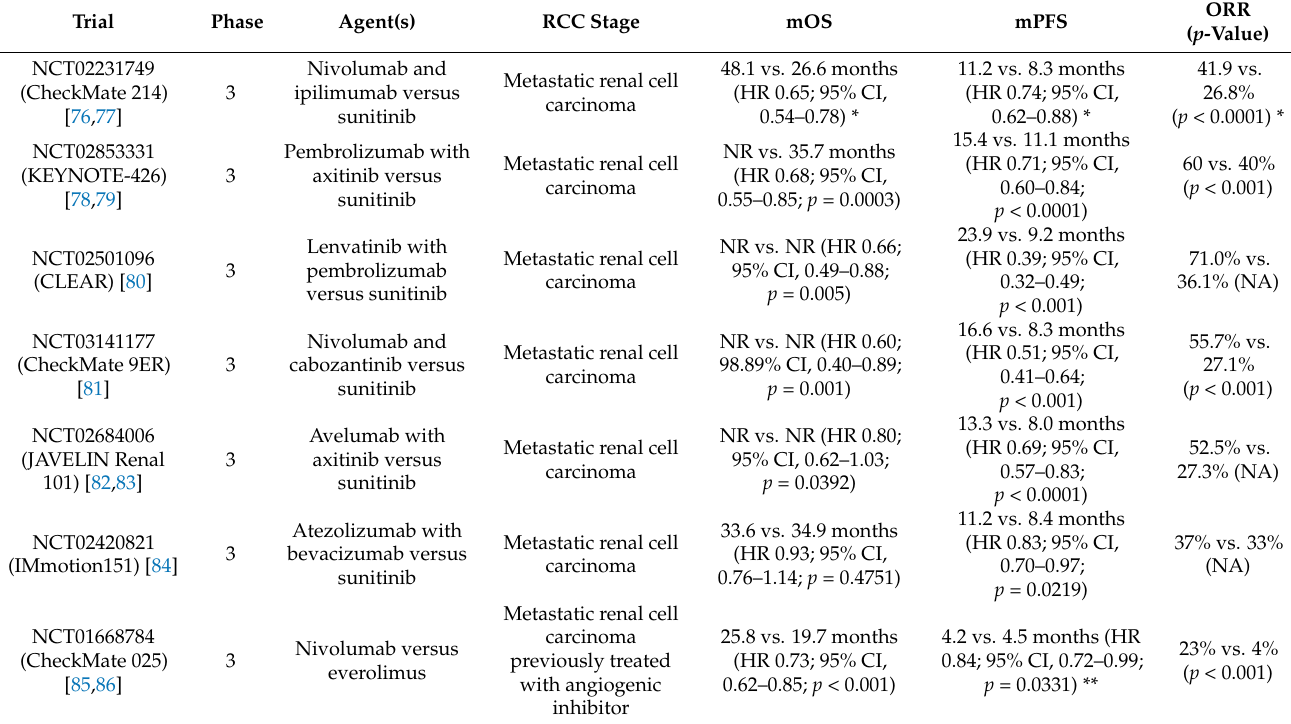
Table 3. Trials with immune checkpoint inhibitors for metastatic renal cell carcinoma (RCC) leading to approval for